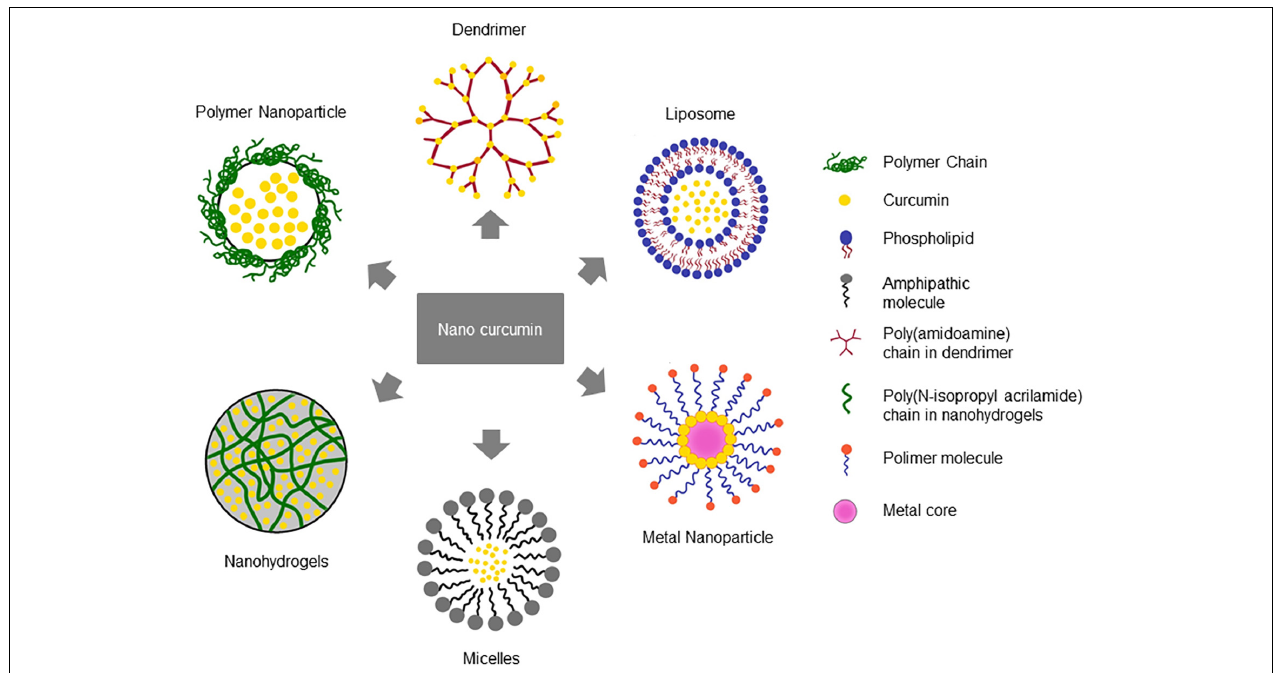
FIGURE 2 | Nanocarrier systems encapsulating curcumin. Different nanoformulation strategies have been reported to improve the bioavailability and therapeutic efficacy of curcumin based on their chemical